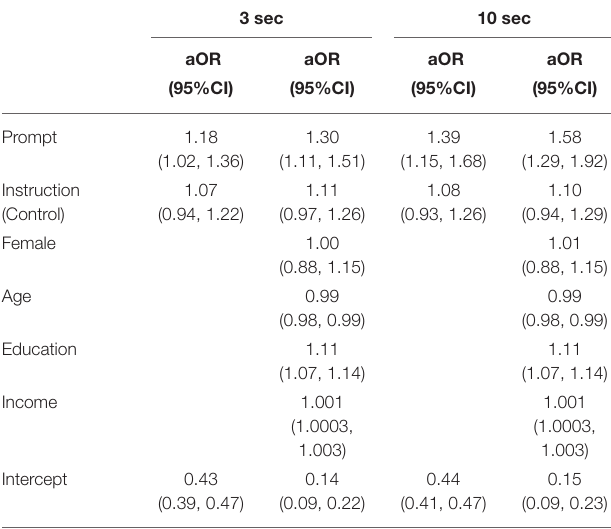
TABLE 4 | The impact of future health consideration on use of nutrition information during food choice in the control condition. All products